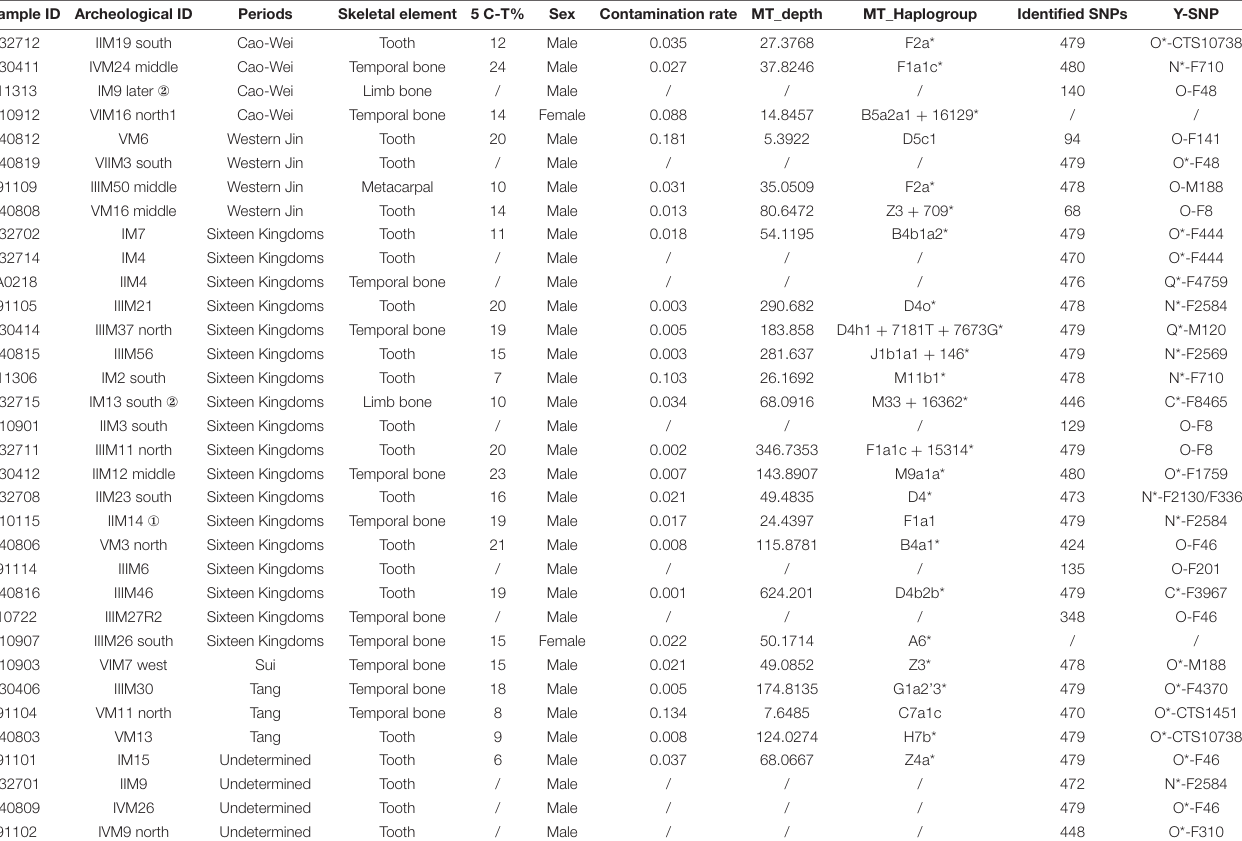
TABLE 1 | Ancient individuals sampled in this study. Sample ID Archeological